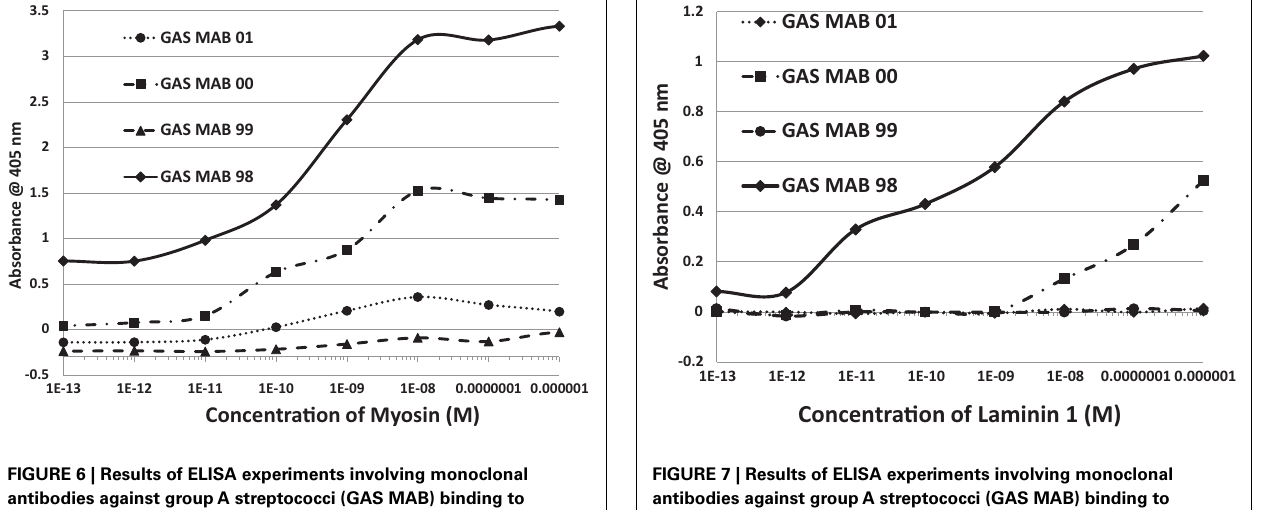
GAS Rabbit-HRP > 10 − 5 Goat anti-Horse-HRP 1 × 10 − 12 Numbers represent the approximate binding constants of the antibodies for each other assuming a molecular weight of 180kD for IgG antibodies and an average of one-to-one binding between antibodies. No pair of monoclonal antibodies (MA or MAB) precipitated each other in the Ouchterlony immunodiffusion experiments. Goat anti-Horse–Horseradish peroxidase-linked antibody binding to horse antibodies is provided as a reference for the binding affinity expected of an antibody to the target against which it was raised.